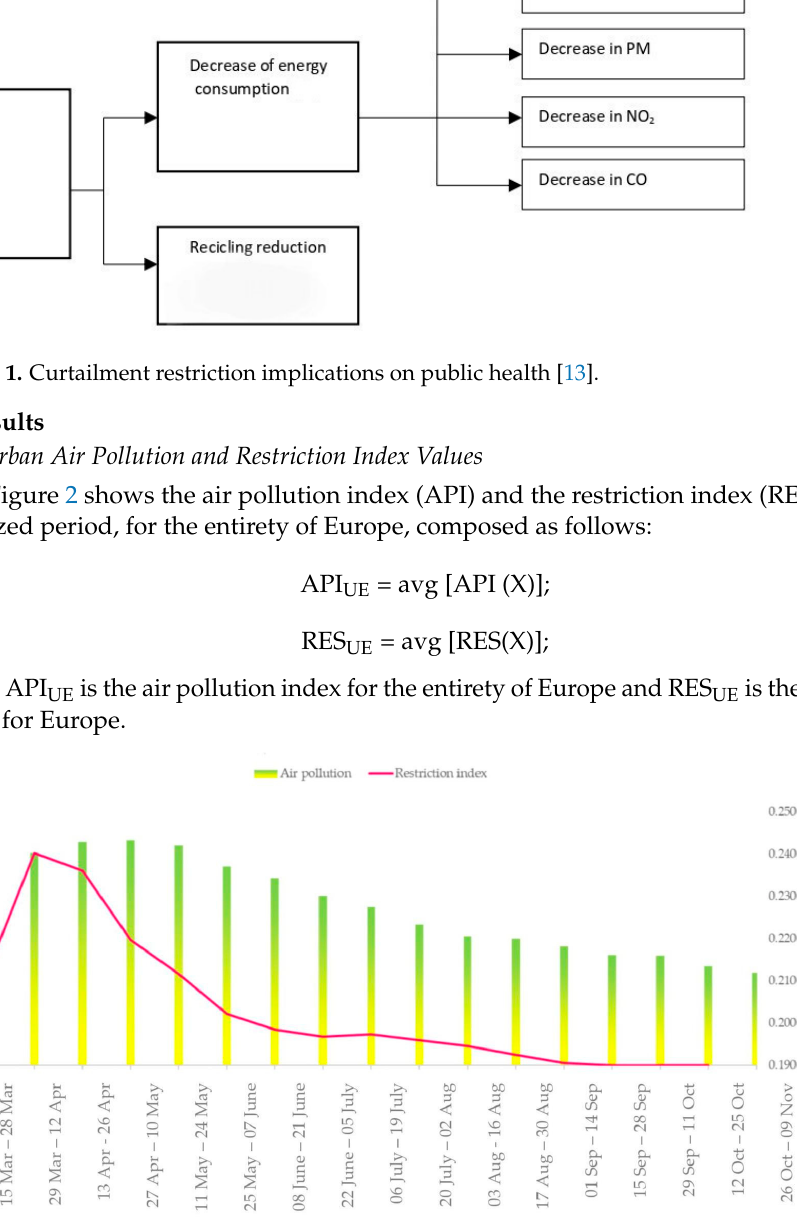
Figure 2. Air pollution (measured as air pollution index) and restrictions (measured as restriction index) during European lockdown and later.